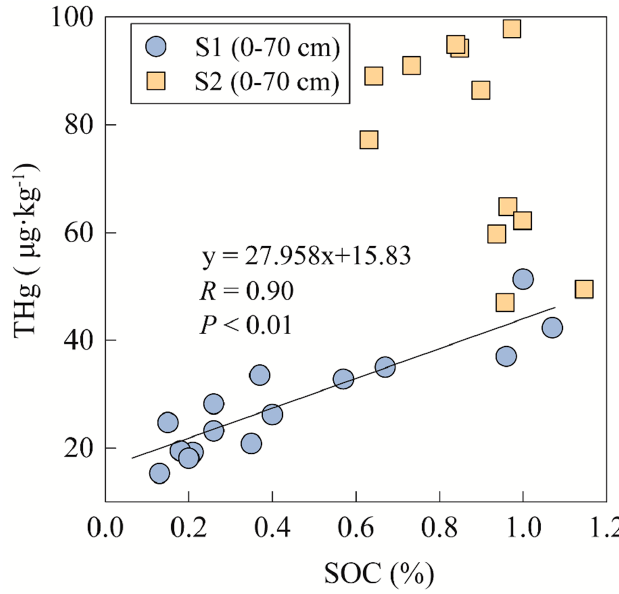
Figure 4. Line regression relationships between the SOC content and THg content in the upper layers (<70 cm) of both forest soil profiles. Int. J. Environ. Res. Public Health 2020 , 17 , x